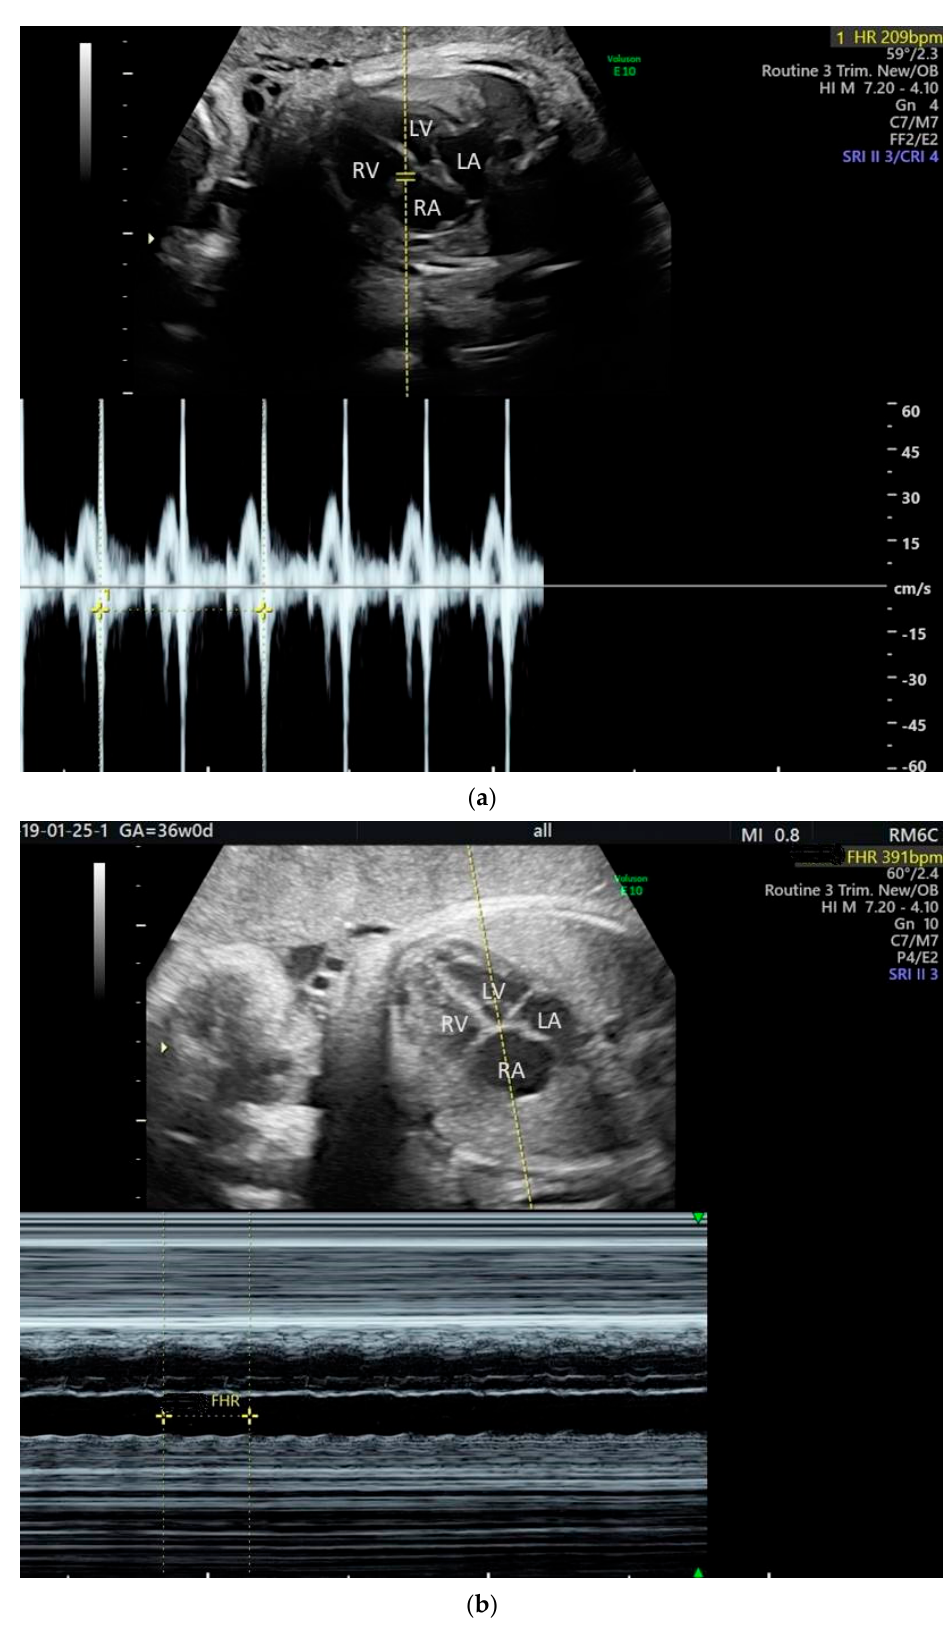
Figure 5. Fetal atrial flutter: ( a ) Pulsed Doppler analysis—ventricular rate; ( b ) M-mode analysis—atrial rate. The treatment of SVT consists of antiarrhythmic medication; the substances used to treat fetal SVT are digoxin, flecainide, sotalol, and, more rarely, amiodarone. Correcting